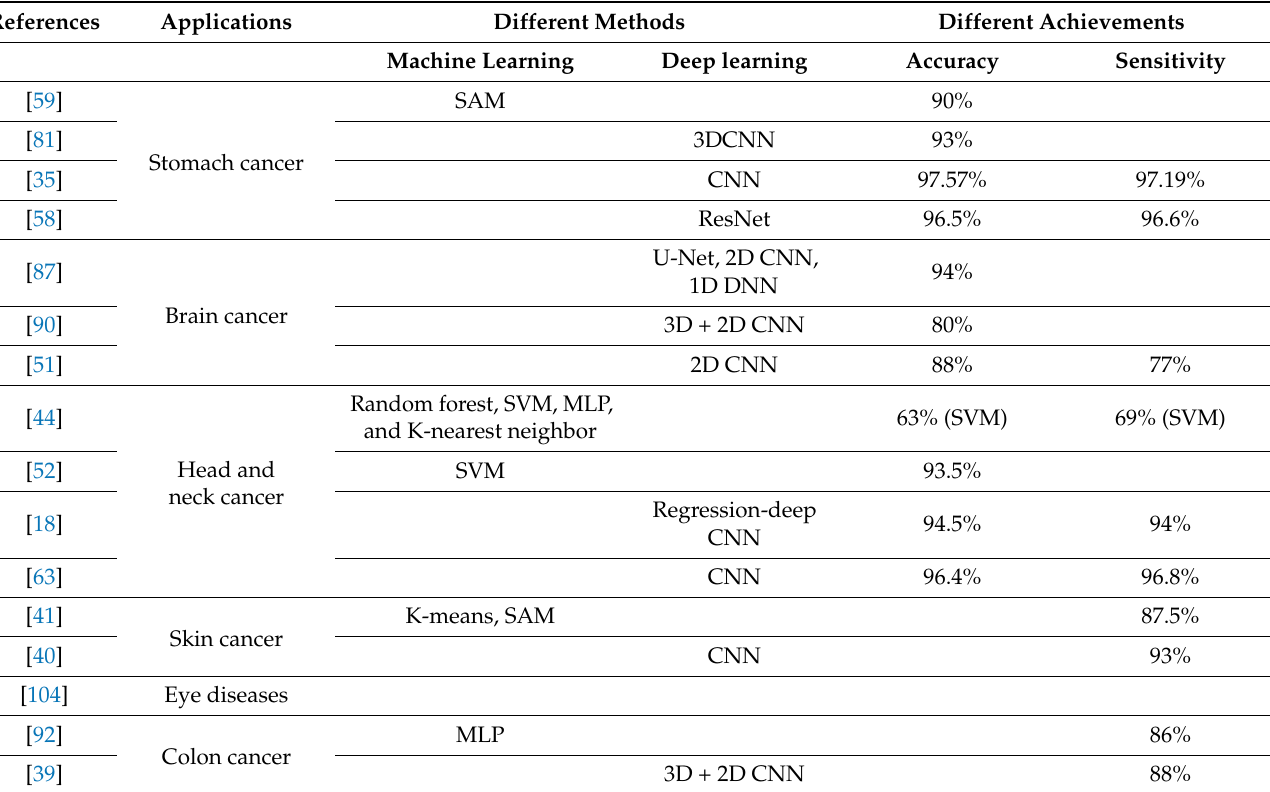
Table 5. Comparison of different methods in the field of medical hyperspectral image applications and different